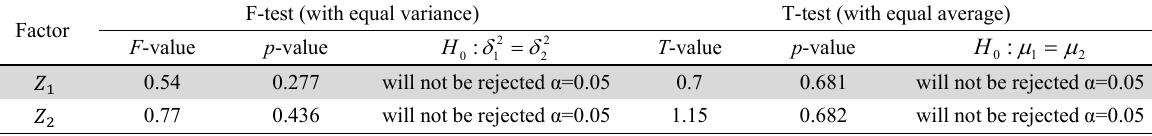
ANOVA for comparing simulation model with real system F-test (with equal variance) T-test (with equal Factor